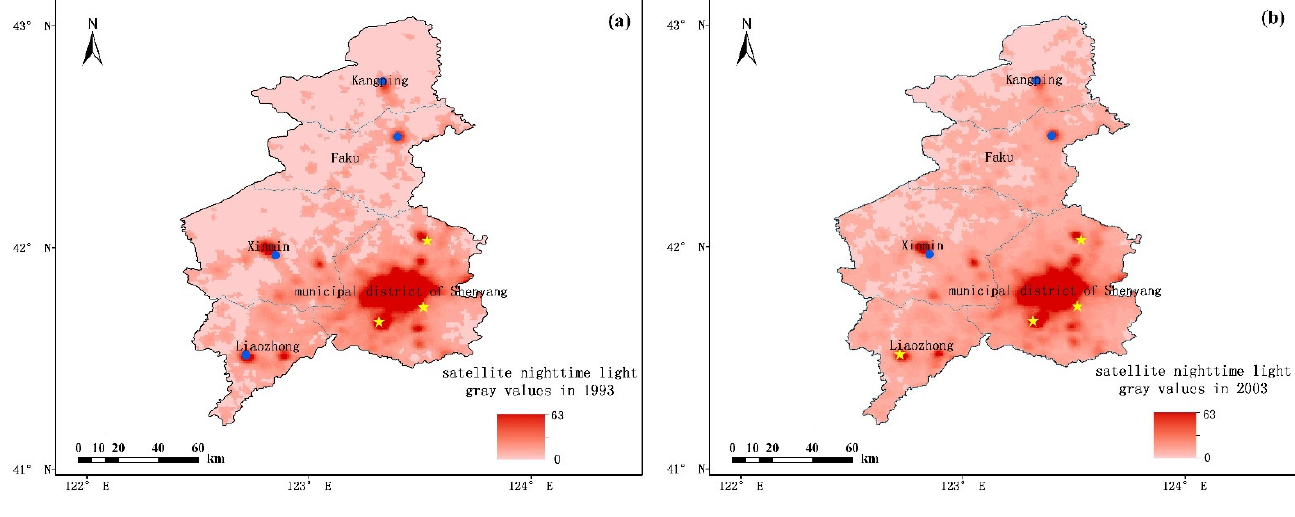
Figure 3. Spatial distributions of satellite nighttime light gray values in Shenyang in 1993, 2003, and 2013 (yellow dots represent urban stations and blue dots represent rural stations). Figure 4. Spatial distributions of ( a ) population density and ( b ) gross domestic product per unit area in Shenyang.